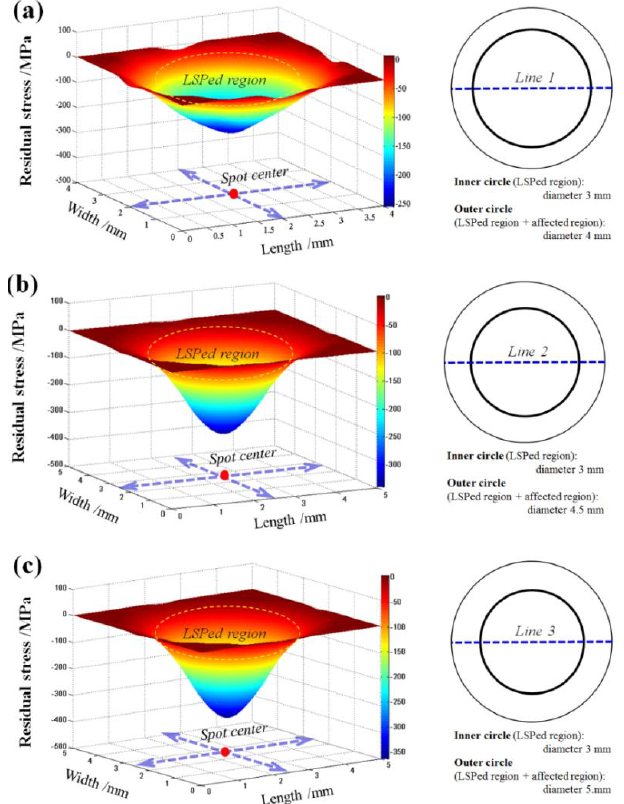
Figure 2. Surface residual stress three-dimensionally displayed distributions at a single laser spot as a function of the number of LSP impacts. ( a ) Single LSP impact; ( b ) dual LSP impacts; and ( c ) triple LSP impacts.